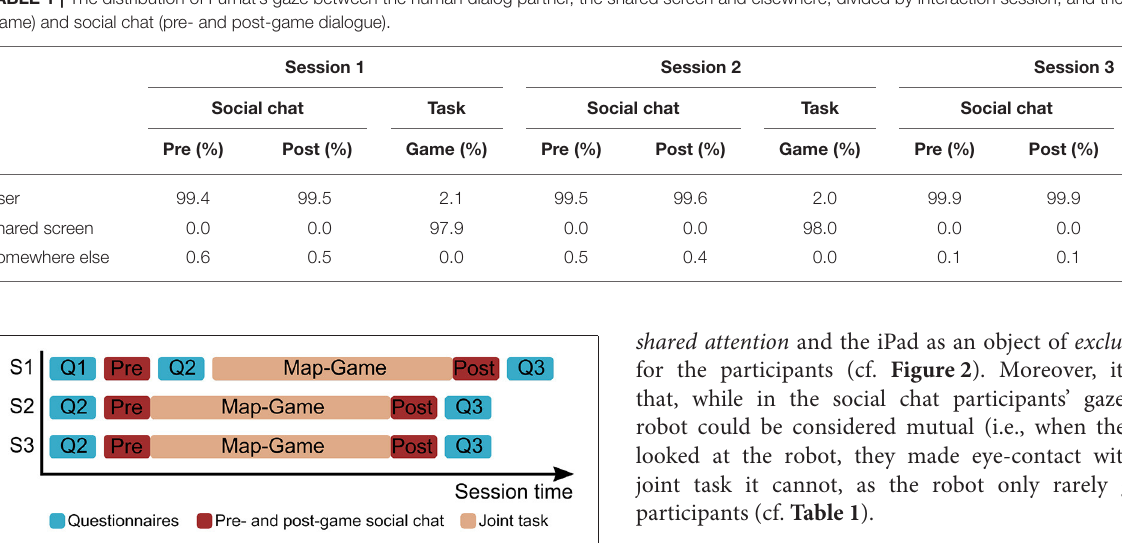
FIGURE 3 | Overview of the study procedure over the three interactive sessions. Note that Q2 in S1 measures the perception of the robot after